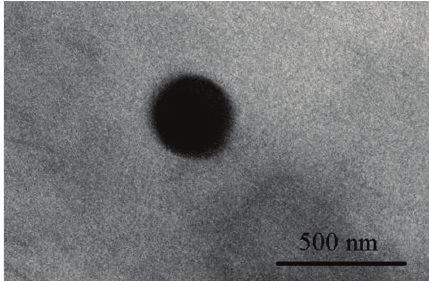
Figure 3: TEM images of Ag-NPs in ethylene